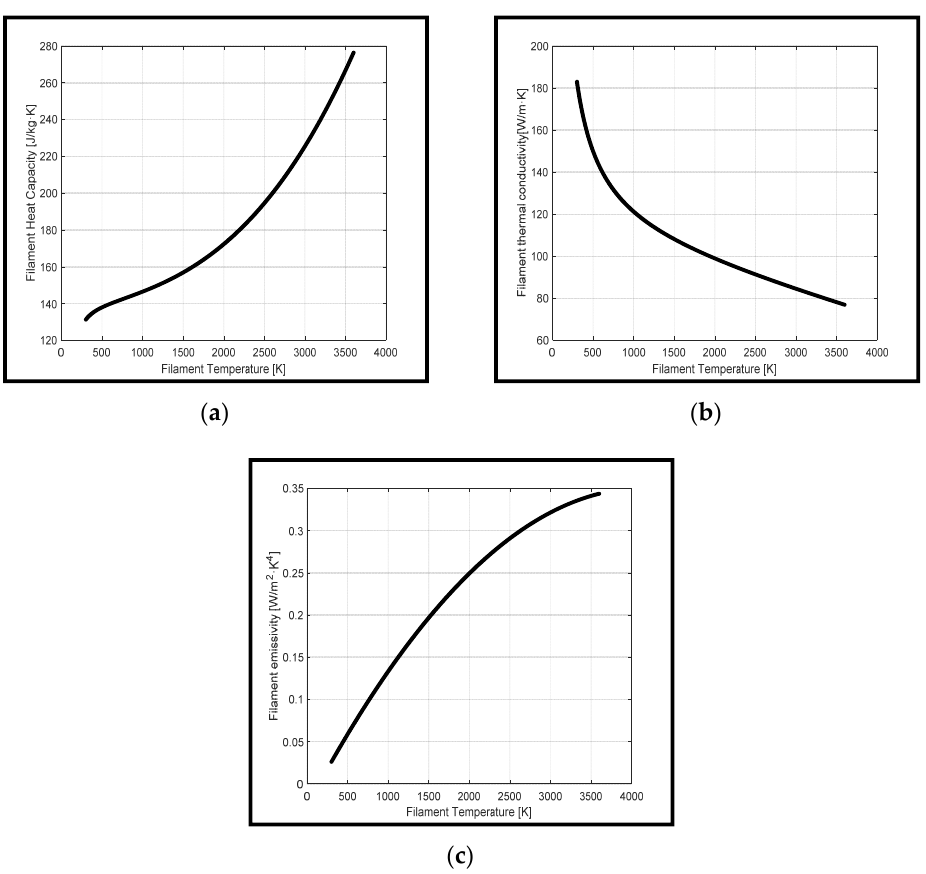
Figure 3. The thermal properties of filament considering the temperature: ( a ) filament heat capacity, ( b ) filament thermal conductivity, and ( c ) filament emissivity.